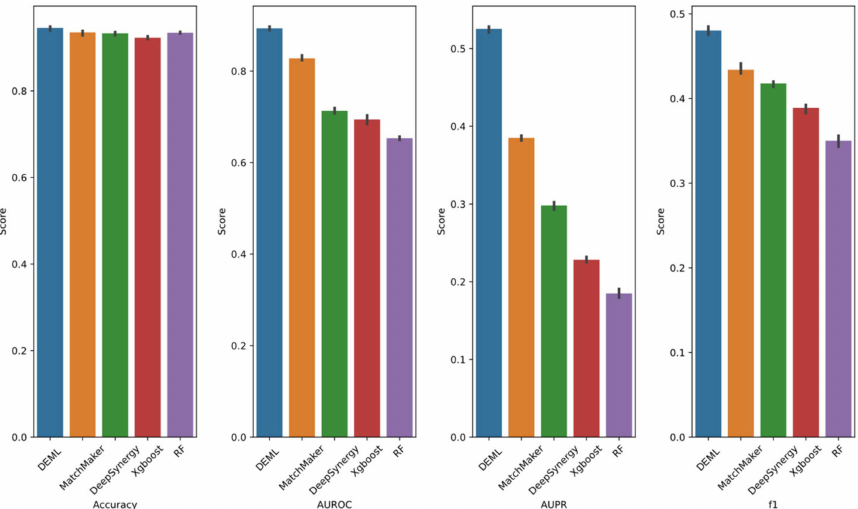
Figure 3. Classification prediction performance of DEML and single-task comparison algorithms in synergy classification prediction task. The error bar represents 95% confidence interval of five-fold